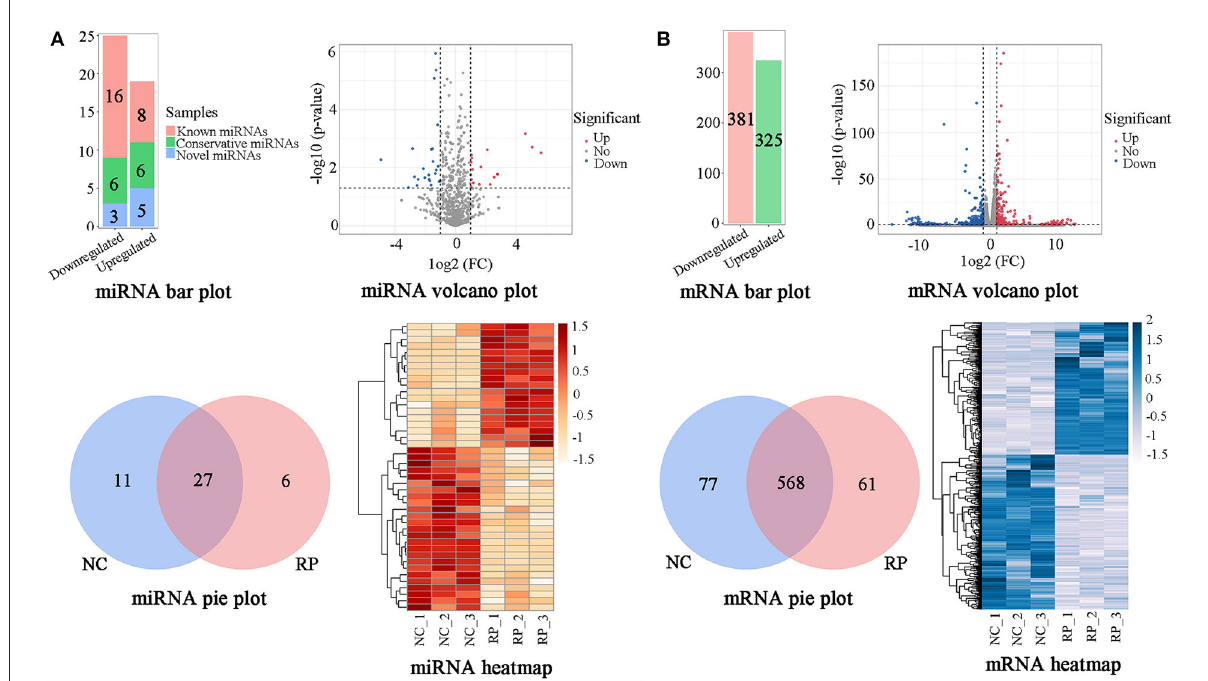
FIGURE2 Classification of DE genes in NC and RP. (A) Numbers, volcano plot, Venn diagram, and heatmap of DE miRNAs. (B) Numbers, volcano plot, Venn diagram, and heatmap of DE mRNAs. The abscissa and ordinate of the heatmap are samples and genes, respectively. The colors from red to white represent the miRNA expression levels [log10 (relative expression levels + 1) and Z -score] from high to low. The colors from blue to white represent the mRNA expression levels [log10 (relative expression levels) and Z -score] from high to low. DE, differentially expressed; FC, fold-change; NC, fetal membranes of normal discharge; RP, retained